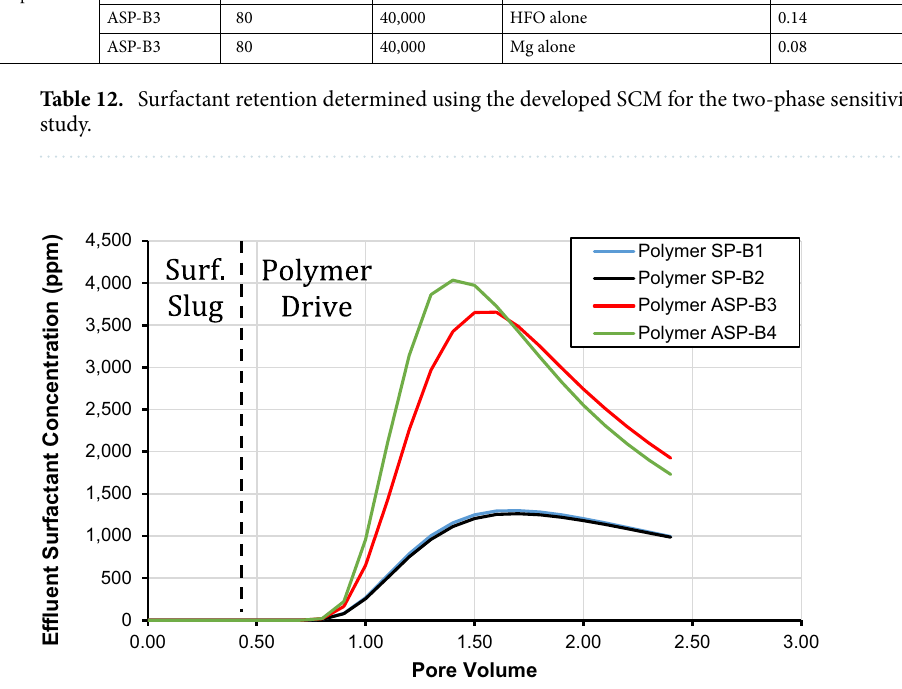
Figure 6. Effect of injected polymer type on effluent surfactant concentration using the developed